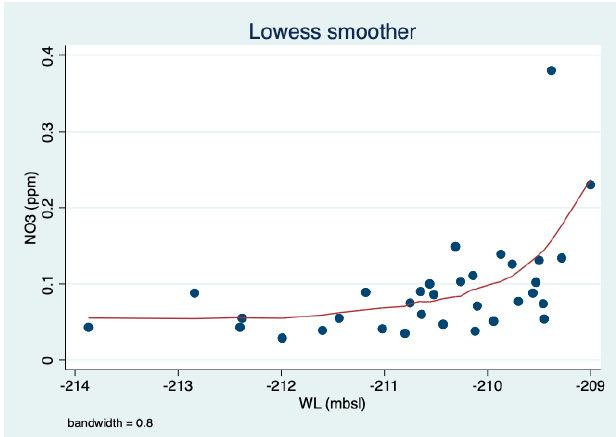
Figure 11. Trend of changes (Lowess smoother, 0.8 bandwidth) of annual lake averages of nitrate (NO 3 ) concentration (ppm scale range: 0.0–0.4) with respect to WL (mbsl) during 1969–2001.